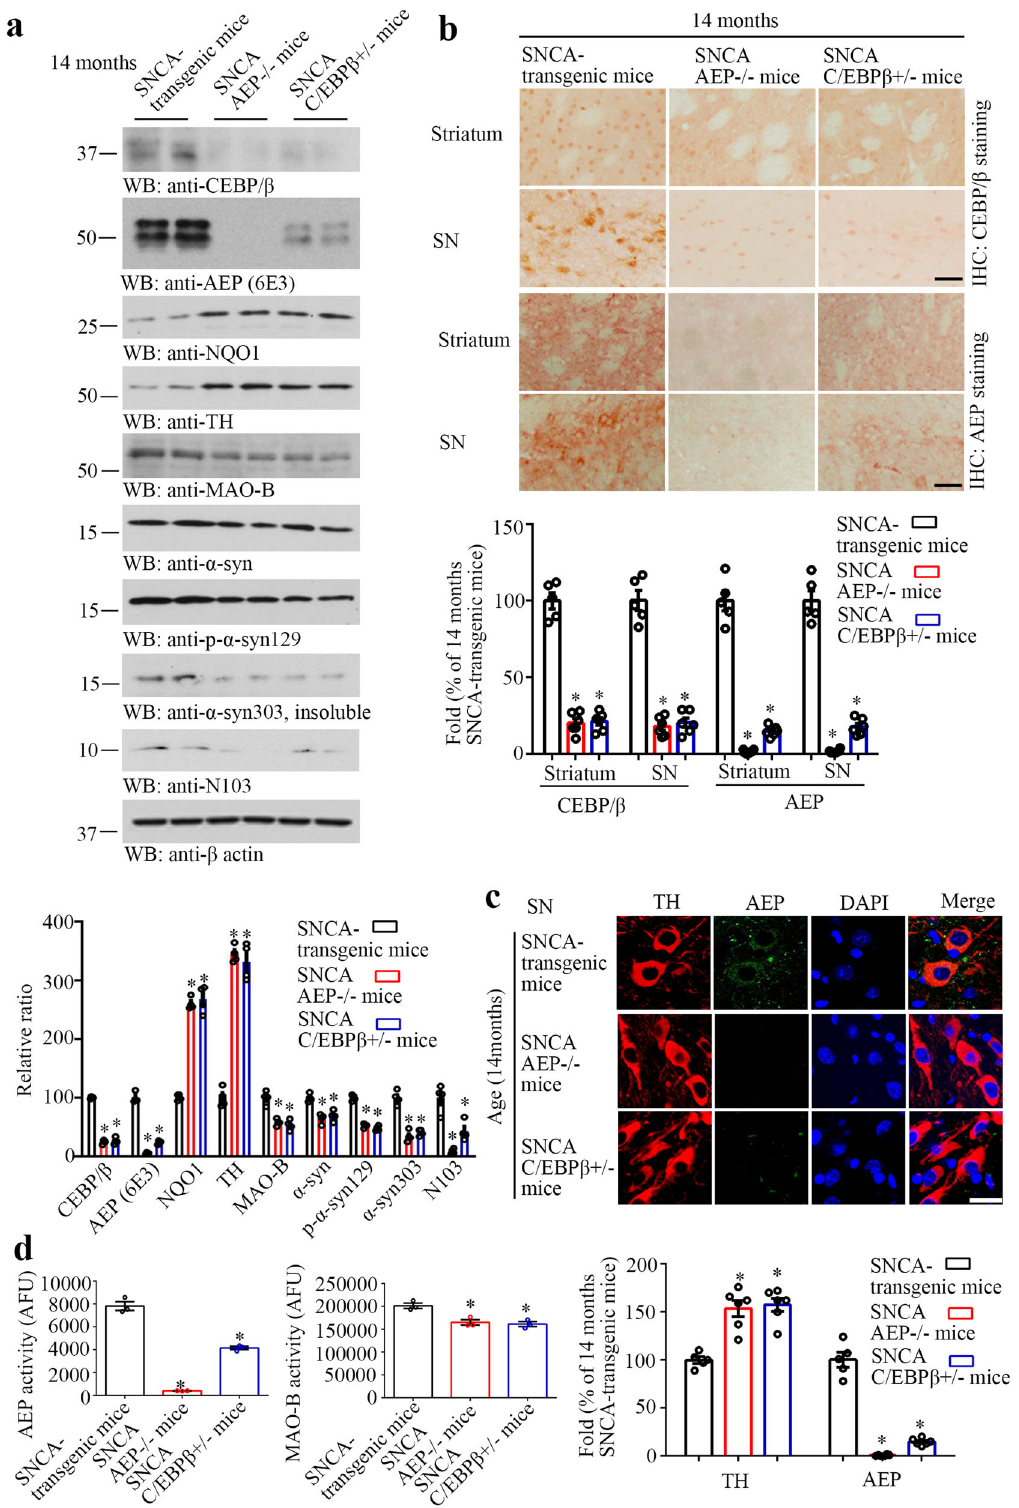
Fig. 2 Inactivation of C/EBP β /AEP pathway rescues dopaminergic neurons in α -SNCA transgenic mice. a Western blot showing C/EBP β , AEP, NQO1, TH, MAO-B, and α -Syn expressing and processing in the brain of α -SNCA transgenic, deletion of AEP and C/EBP β ± from α -SNCA transgenic mice. Quanti fi cation of western blotting ( n = 4 per group, * P < 0.05 vs 14 months old α -SNCA transgenic mouse, one-way ANOVA). b Immunohistochemistry and the quanti fi cation of C/EBP β and delta-secretase in the striatum and SN ( n = 5 – 6 per group, * P < 0.05 vs 14 months old α -SNCA transgenic mouse, one-way ANOVA). Scale bar, 50 μ m. c Immuno fl uorescent staining and the quanti fi cation of TH and AEP in SN (mean ± s.e.m.; n = 5 – 6 per group, * P < 0.05 vs 14 months old α -SNCA transgenic mouse, one-way ANOVA). Scale bar, 20 μ m. d AEP and MAO-B activity assay in the SN samples (mean ± s.e.m.; n = 3 per group, * P < 0.05 vs 14 months old α -SNCA transgenic mouse, one-way